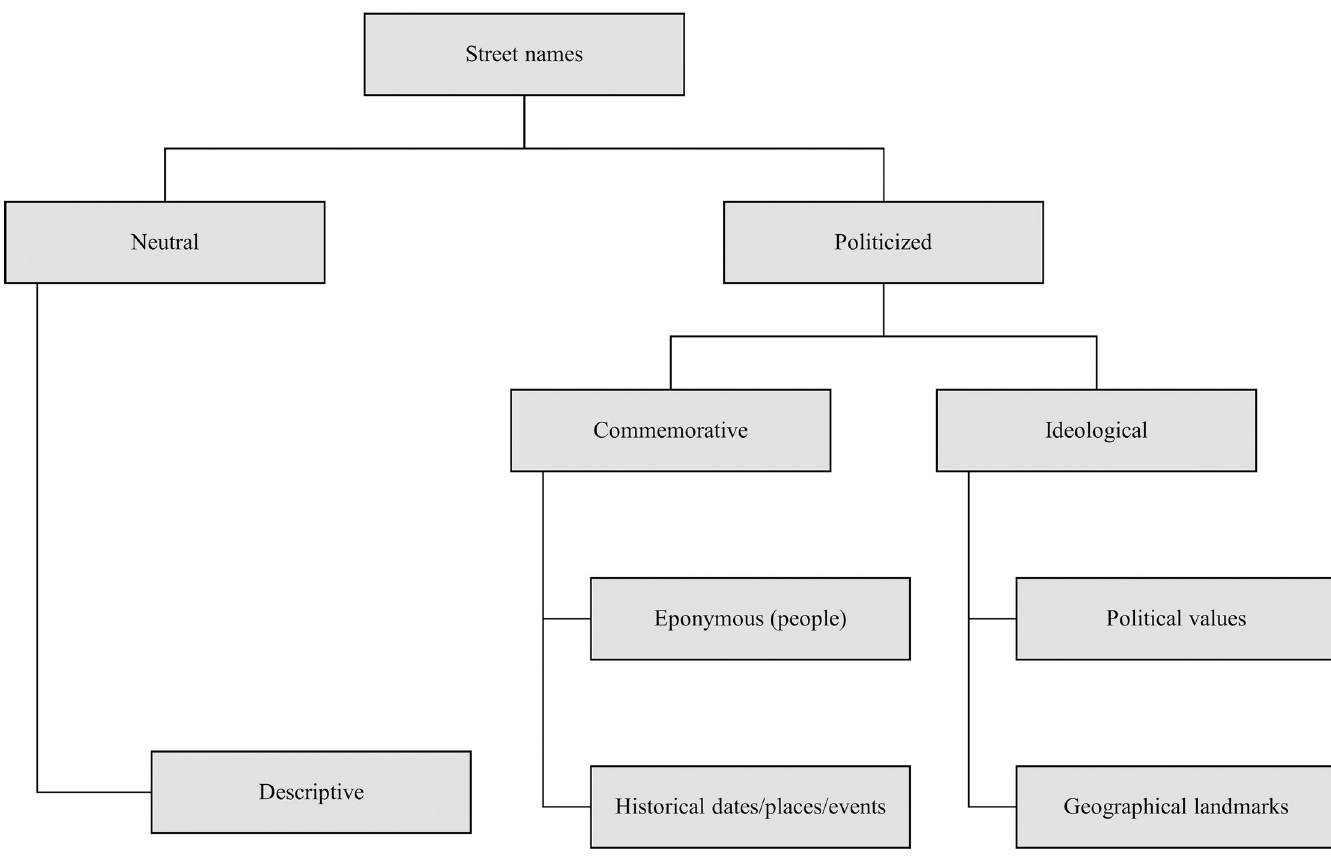
Fig 1. The hierarchical typology of street names (coding